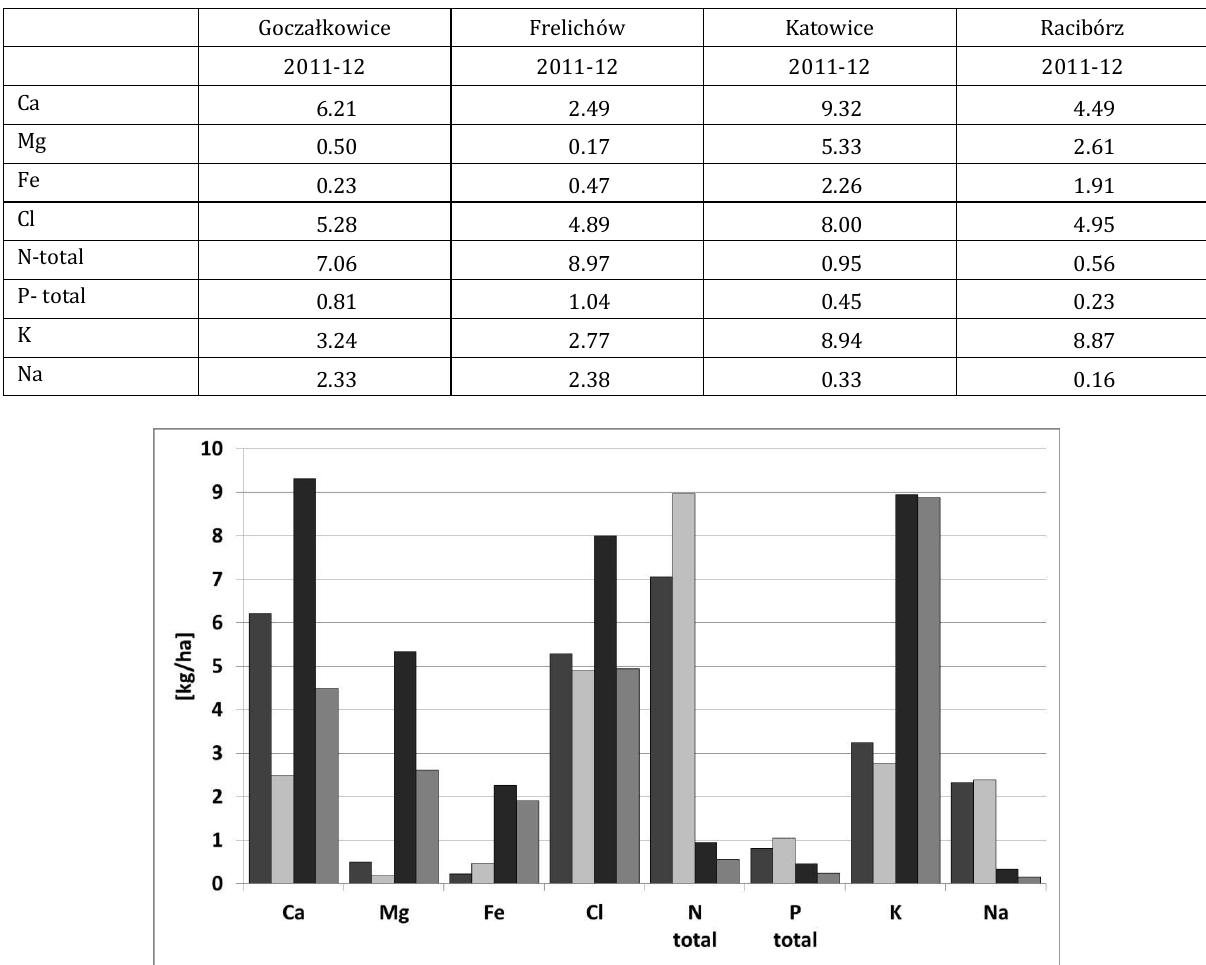
Table 1. Total values of pollutant load in 2011 and 2012 for Goczałkowice, Frelichów, Katowice and Racibórz [kg·ha -1 ]